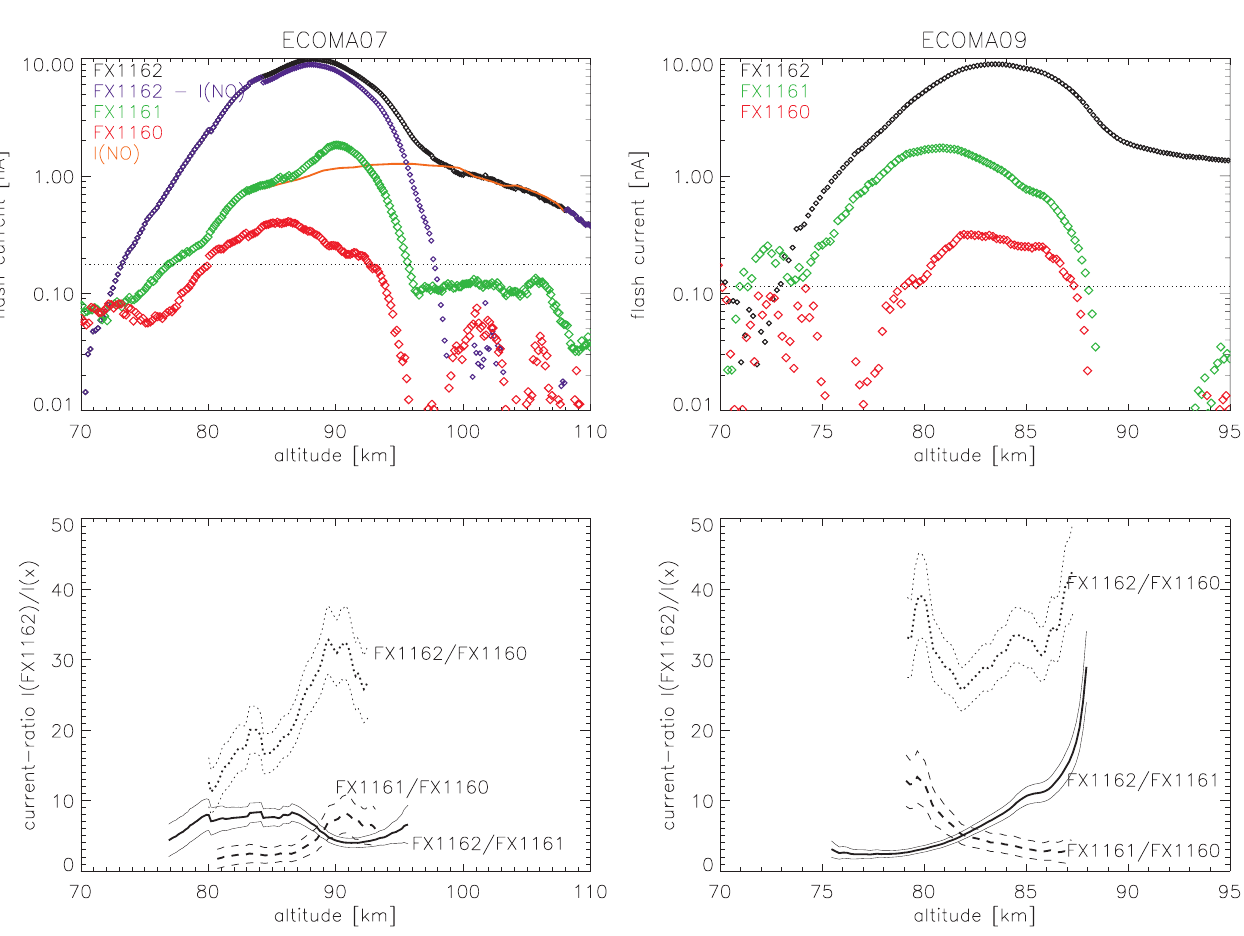
Fig. 8. Upper panels: Photoelectron currents measured during flights ECOMA07 (left) and ECOMA08 (right). Black, green and red symbols indicate currents owing to different flashlamps (see legend). The dotted horizontal line marks the 2 σ -noise level of the unsmoothed mea- surements. In the upper left panel, the orange curve further shows the current-contribution from NO which was independently measured with photometers by the Stockholm group. Unfortunately, such data are not available for ECOMA09. The dark blue symbols mark the data of the FX1162 flashlamp corrected for the contribution owing to NO. Lower panels: Profiles of current ratios along with their 2 σ -error bars, for altitude ranges in which both measurements exceeded the 2 σ -noise level of the unsmoothed